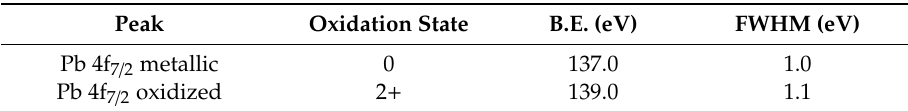
Figure 15. Pb 4f 7/2 narrow scan ( left ); and Br 3d narrow scan ( right ). Table 12. B.E. values for